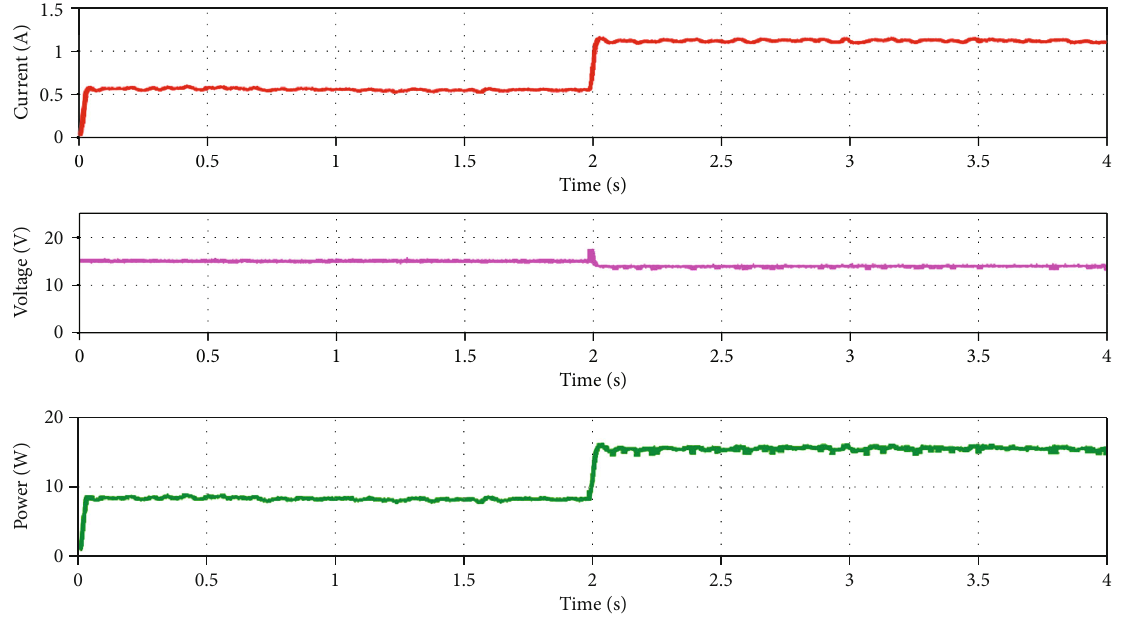
Figure 23: Experimental results (current, voltage, and power) of the modi fi ed MPPT controller under load variation